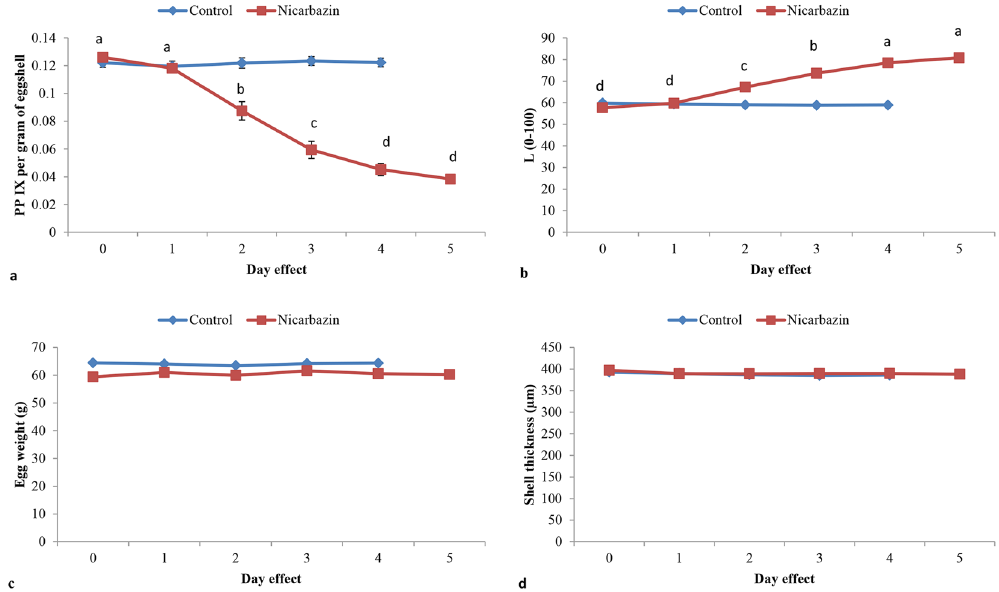
Figure 3. Eggshell quality variables measured in control and nicarbazin treated laying hens affected by day effect. ( a ) PP IX per gram of eggshell (nMoles) between the control (P = 0.9512) and nicarbazin (P < 0.0001) treated hens. ( b ) L * values for eggshells between the control (P = 0.7026) and nicarbazin (P < 0.0001) treated hens. ( c ) Egg weight between the control (P = 0.9683) and nicarbazin (P = 0.6414) treated hens. ( d ) Shell thickness of eggshells between the control (P = 0.8345) and nicarbazin (P = 0.8600) treated hens. Values are mean and bars represent standard error. Different superscripts (a, b, c, d) show significant